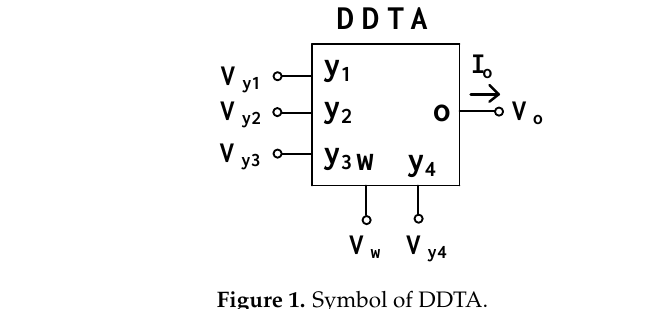
Figure 1. Symbol of DDTA.